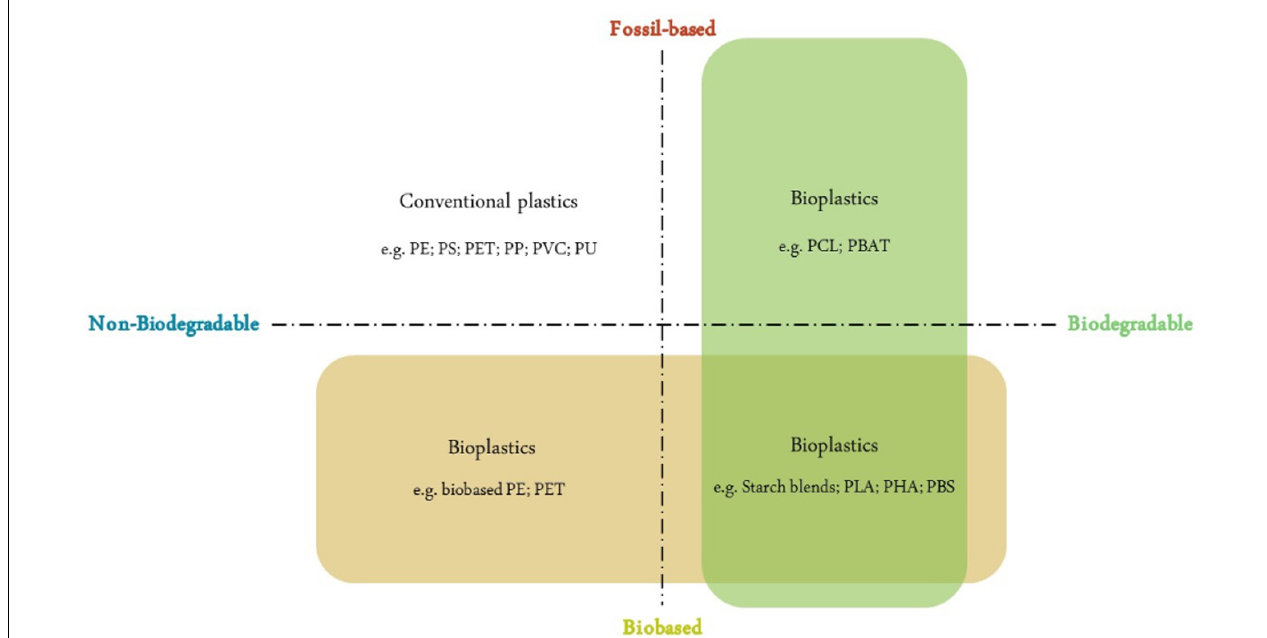
FIGURE 7 | Degradable and non-degradable relations of fossil-based and biobased plastics types. PE, polyethylene; PS, polystyrene; PET, polyethylene terephthalate; PP, polypropylene; PVC, polyvinyl chloride; PU, polyurethane; PCL, polycaprolactone; PBAT, polybutyrate adipate terephthalate; PLA, polylactic acid; PHA, polyhydroxyalkanoates; PBS, polybutylene succinate.